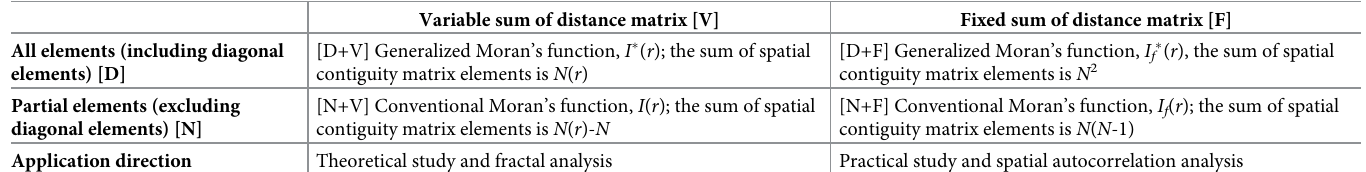
Table 1. Four possible types of calculation approaches to spatial autocorrelation functions based on different diagonal elements and means of spatial contiguity matrix. Variable sum of distance matrix